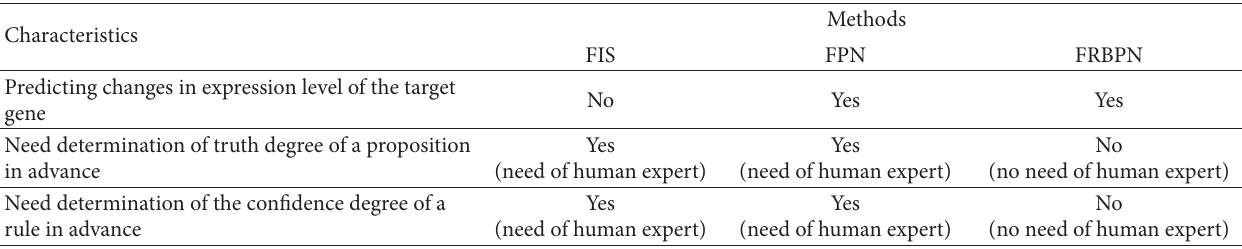
Table 2: Comparison of pure FIS versus FPN and